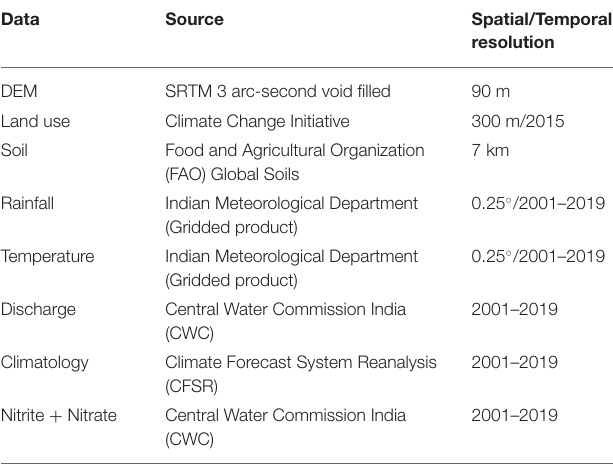
TABLE 1 | Description of the datasets used in the study.